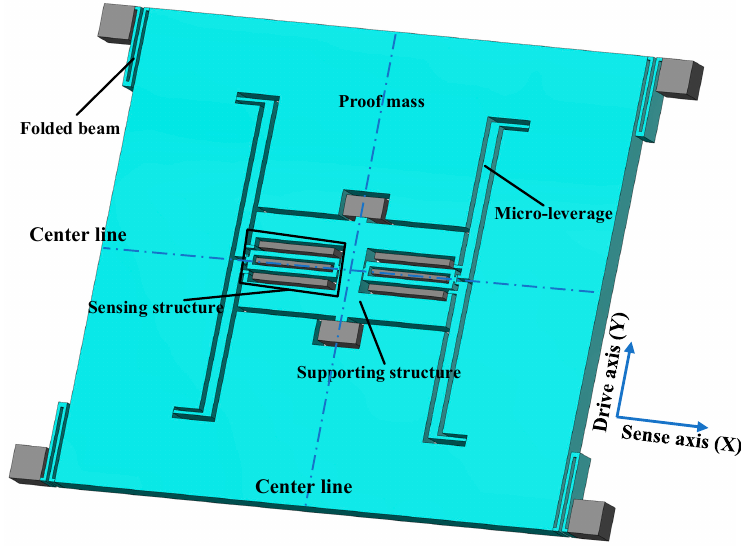
Figure 1. Schematic view of the designed silicon resonant accelerometer.